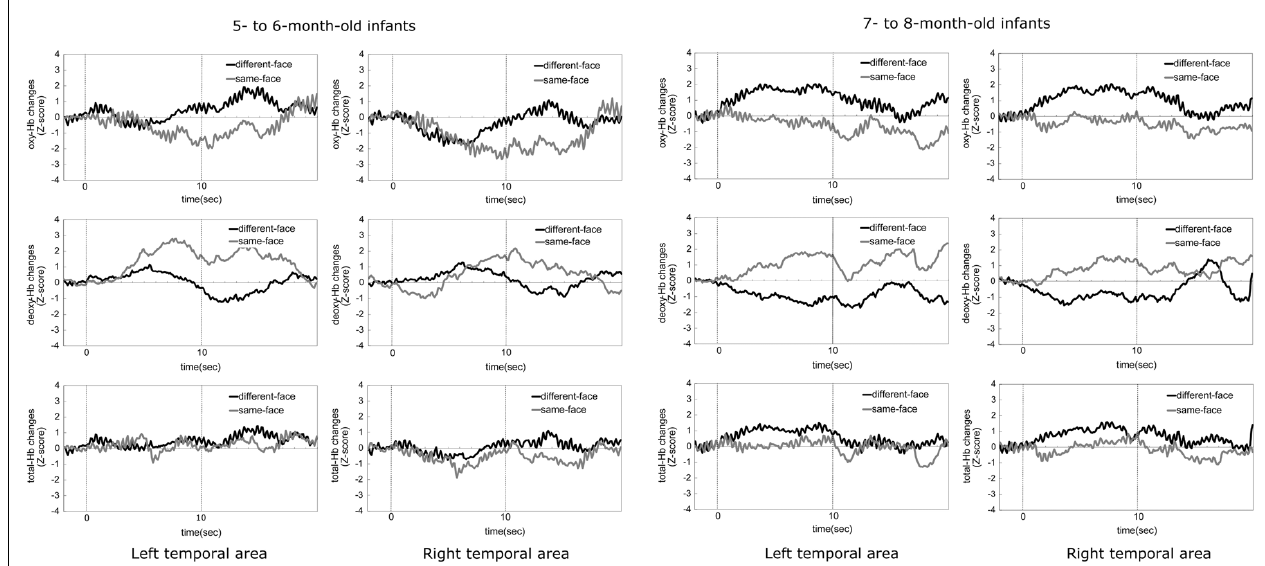
the middle part for deoxy-Hb, and the two graphs in the bottom part for total-Hb.The data for the left temporal area are shown in the left column and those for the right temporal area are shown in the right column. In each graph, the black line represents the mean Z -score of the different-face condition and the gray line represents that of the same-face